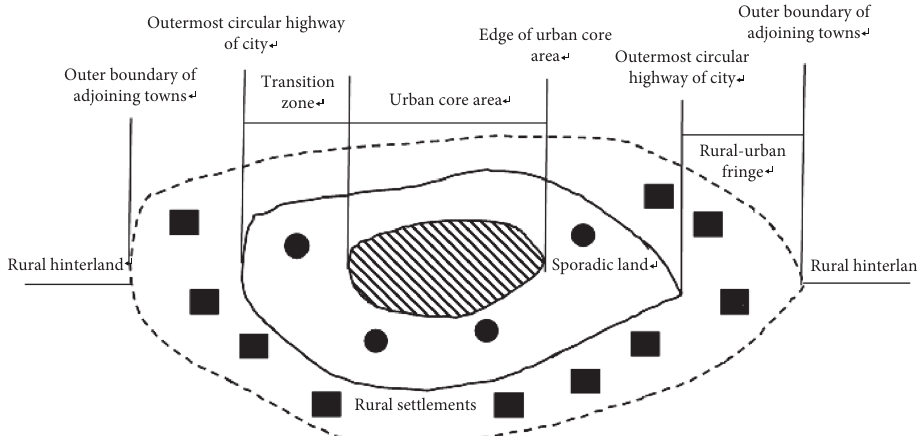
Figure 1: Schematic diagram of rural-urban fringes.